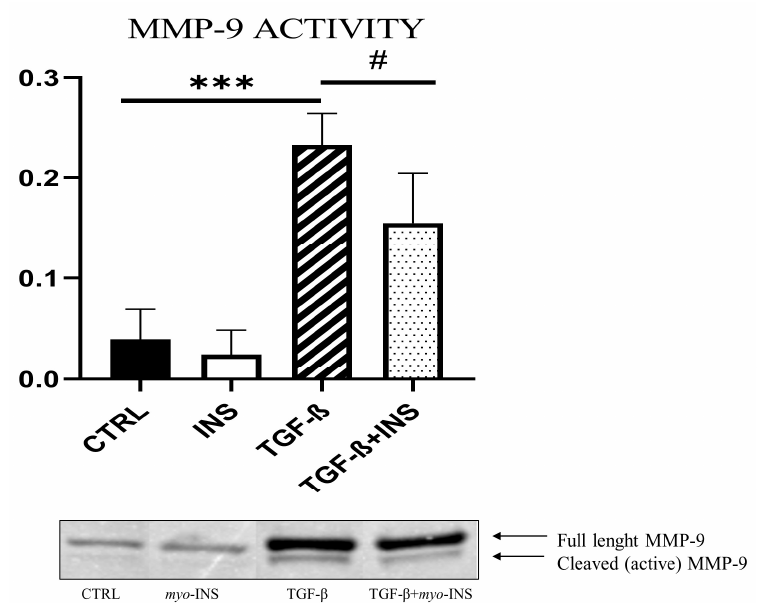
Figure 6. Myo-Ins decreases the proteolytic activity of MMP9. The histograms represent the MMP-9 activity in MCF-10A cells and in control MCF-10A cells treated with TGF- β 1 alone or in combination with myo-Ins. Whereas TGF- β 1 induce a five-fold increase in MMP-9 release, myo-Ins significantly mitigates this effect by ~40%. One-way ANOVA statistical analysis: *** p < 0.001. The uncropped blots are shown in Figure S2. # p < 0.05. Legend: *: TGF- β 1 vs. CTRL; #: TGF- β 1+myo-Ins vs. TGF- β 1.